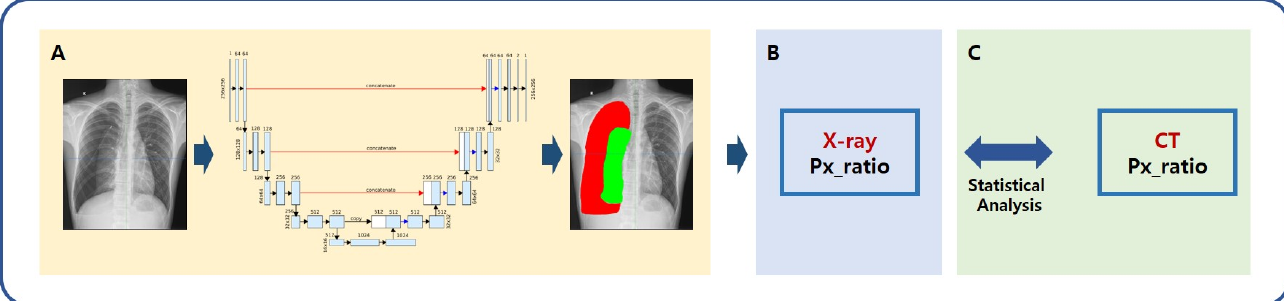
Figure 1. Schematic of AI modeling study for the measurement of pneumothorax. ( A ) A deep learning framework using the U-Net architecture segmented lung and pneumothorax on chest ra- diographs; ( B ) Quantitative value of pneumothorax was calculated using the predicted label; ( C ) The pneumothorax values calculated from the predicted label and gold standard were compared. The pneumothorax value (volume ratio) was defined as the gold standard based on a CT image. The pneumothorax value (area ratio) based on a simple chest image was defined as a true label. The two values were derived from manually segmented labels, while AI was used to derive the predicted label of pneumothorax value (area ratio) on simple chest images. X-ray = simple chest radiography, Px_ratio = pneumothorax ratio, CT = chest computed tomography. 2.3. AI Modeling for Pneumothorax Pneumothorax labeling (true label; area ratio by simple chest radiography, gold standard; volume ratio by chest CT) was performed by a radiologist with more than 15 years of experience to develop an AI model that predicts the amount of pneumothorax and recommends a treatment method. An AI model was developed using a deep learn- ing method trained with true labels. Subsequently, the AI-predicted pneumothorax was defined as a predicted label, and the values were compared and analyzed (Figure 2). Figure 2. Deep learning model for automatic differentiation and segmentation of pneumothorax. 2.3.1. Deep Learning Architecture with the Images Preprocessing Method This study used the U-Net architecture because of its significantly accurate medical image segmentation at various anatomical sites, including the chest [19,20]. It was used to examine and classify pneumothorax, normal lung, and other lesions presented on a simple chest radiograph. The following preprocessing steps were performed for effective segmentation. The feature values of images such as points, edges, corners, textures, and colors were more consistent through histogram matching, and contrast was enhanced through histogram equalization. Then, the brightness interval between two consecutive pixel values was adjusted using the window setting. Images with pixel normalization and resizing were used as inputs for deep learning models. We tested several hyperpa- rameters to train the optimal deep learning model, and those with the best performance